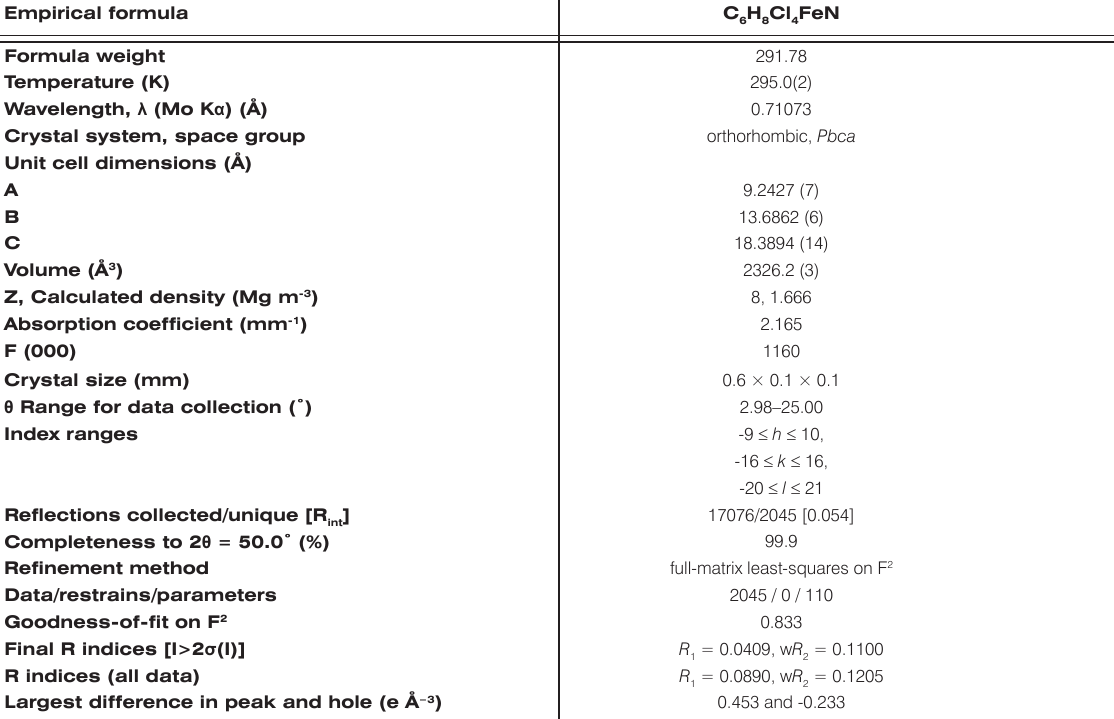
Table 1. Crystal data and structure refinement for [2-Me(Py)H][FeCl